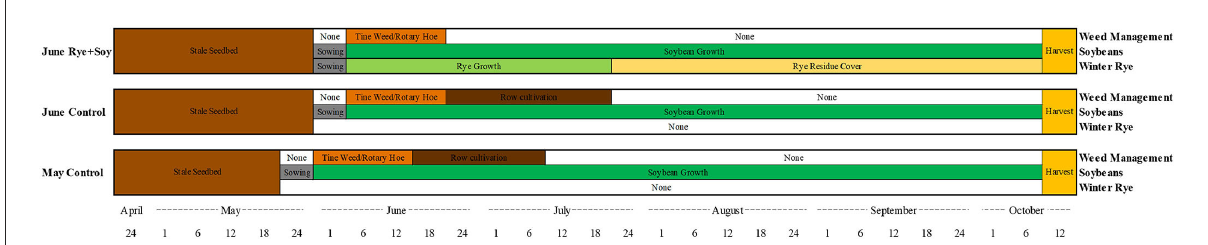
FIGURE2 Cropping systems diagram illustrating conceptual differences and timing of weed control activities, soybean growth, and winter rye cover when managed under three experimental treatments (June Rye + Soy, June Control, and May Control) as implemented at the Arlington